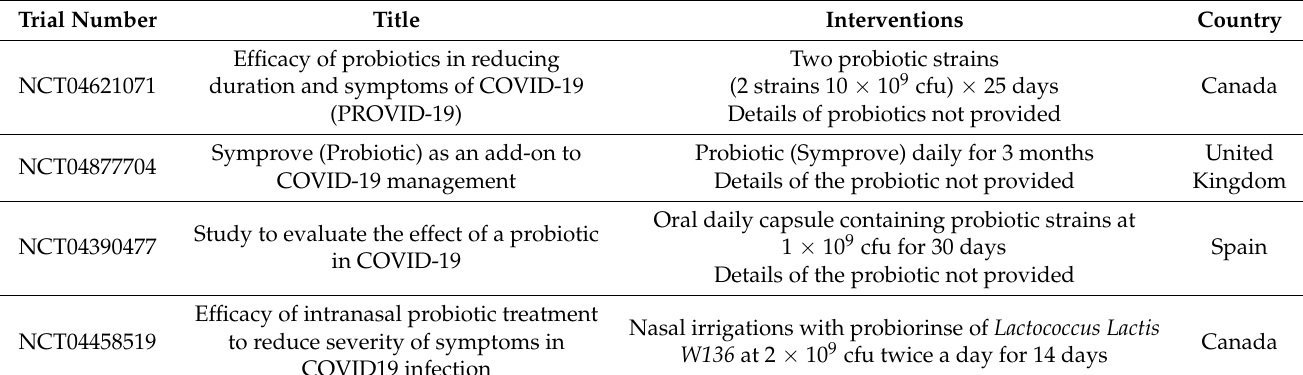
Table 1. Clinical trials of probiotics for COVID-19 (ClinicalTrials.gov, accessed on 15 May 2021). Trial Number Trial